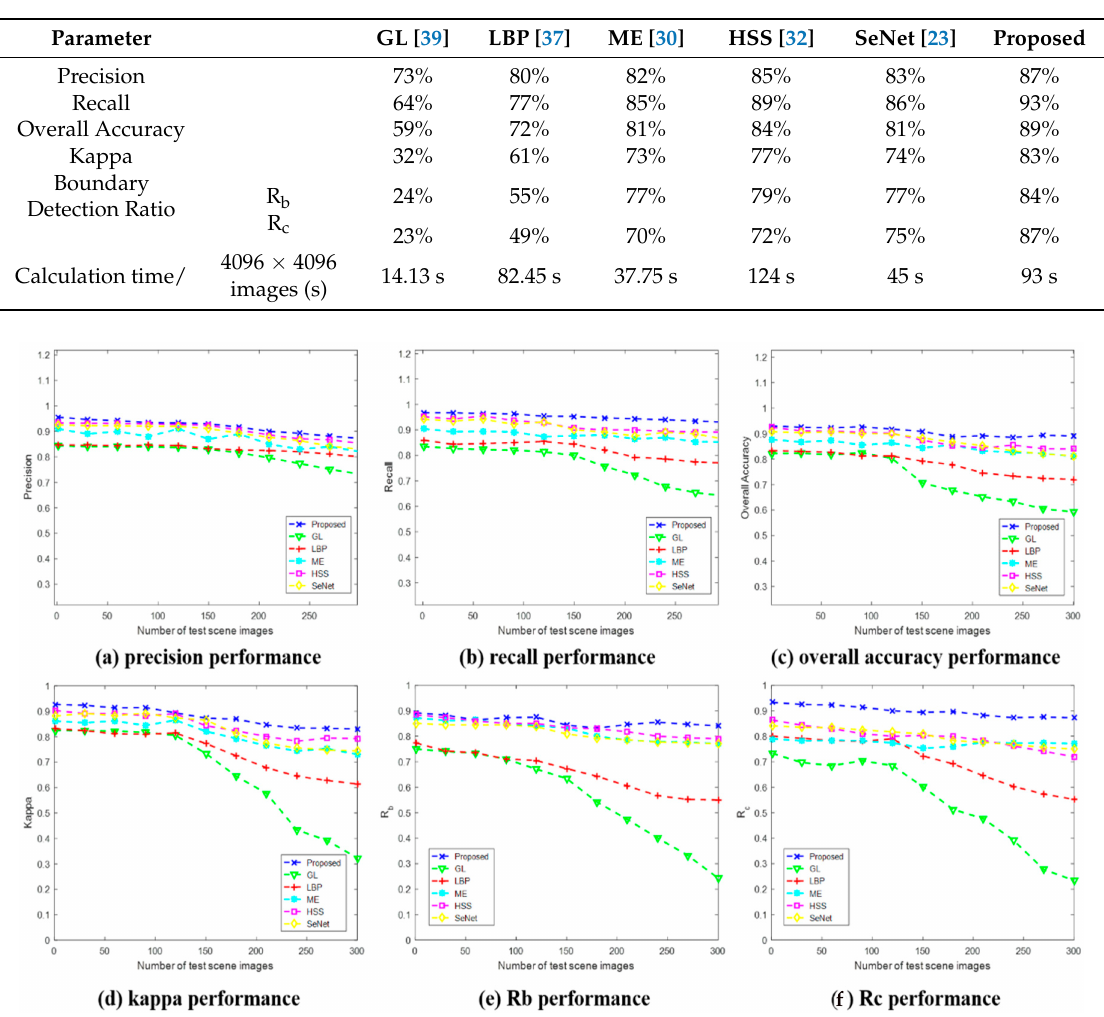
Table 4. Performance comparison for refined water body extraction.